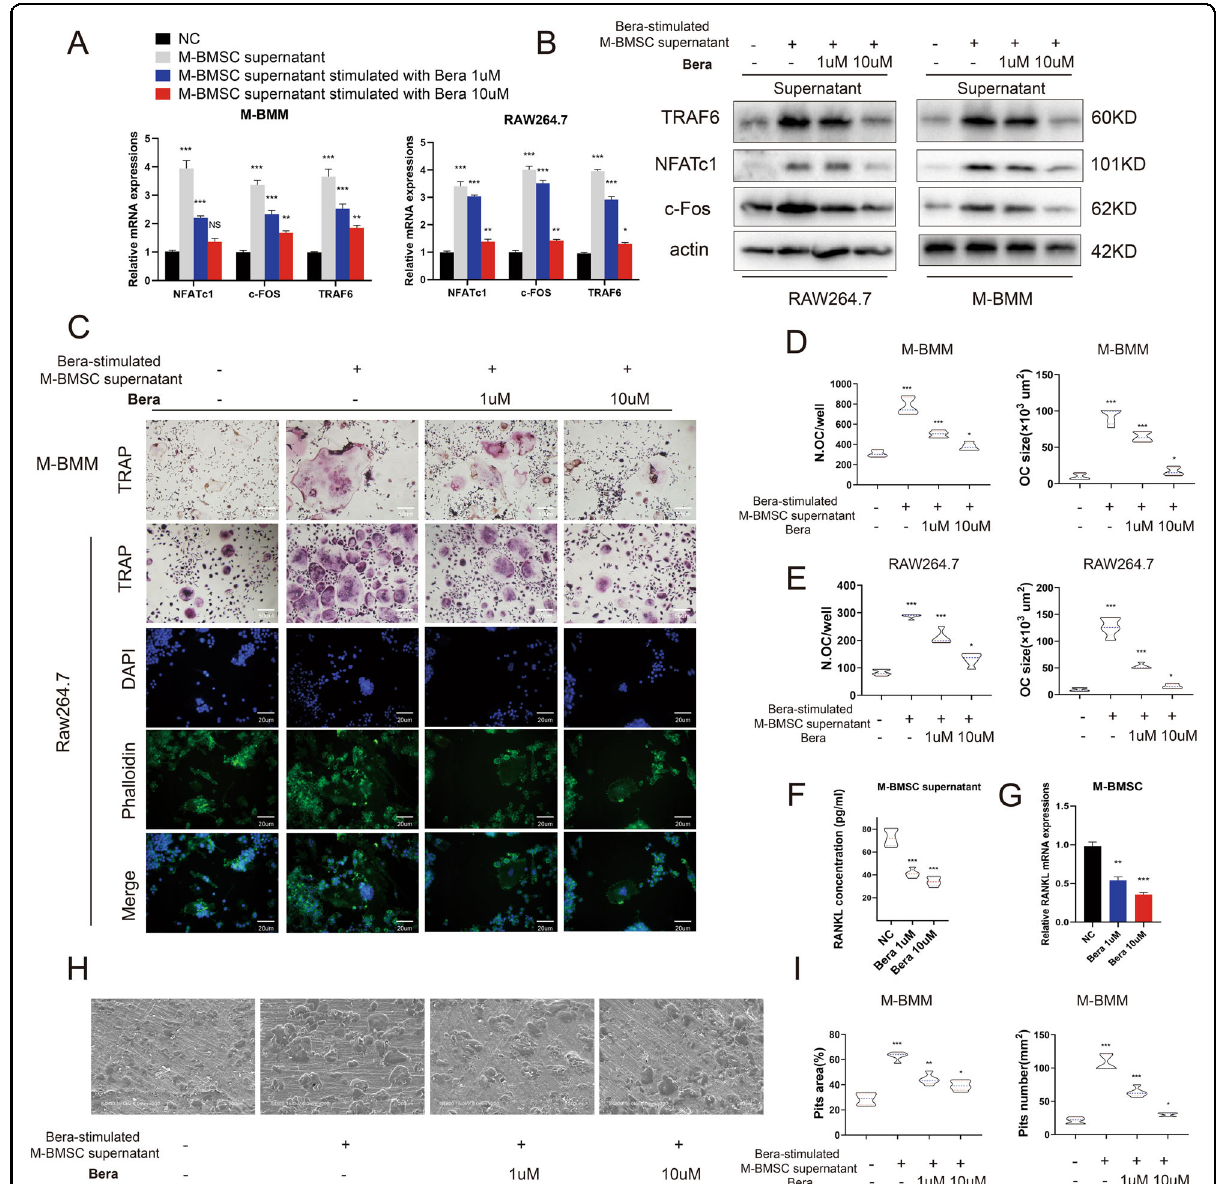
Fig. 4 Beraprost promotes osteoclast differentiation through BMSCs in vitro. A Quantitative RT-PCR analysis of mRNA expression of TRAF6, NFATc1, and c-Fos in M-BMM and Raw264.7 cells cultured with the supernatant of beraprost-stimulated M-BMSCs. Results are shown as mean ± SD. n = 5; * P < 0.05, ** P < 0.01, and *** P < 0.001 by ANOVA with Tukey ’ s post-hoc test. B Western blotting images showing protein expression of TRAF6, NFATc1, and c-Fos in M-BMM and Raw264.7 cells cultured with the supernatant of beraprost-stimulated M-BMSCs. C Representative images of TRAP staining in M-BMM and Raw264.7 after 7 days of osteoclast differentiation in the presence of M-BMSCs supernatant stimulated with beraprost. Scale bar, 50 µm. Representative images of fl uorescent staining of Raw264.7 cells are shown. The cytoskeleton was stained with FITC-conjugated phalloidin and the nucleus was stained with DAPI. RANKL (30 ng/mL) was used in all groups. Scale bar, 20 µm. D , E Number and size of osteoclasts. TRAP- positive cells with at least three nuclei were de fi ned as osteoclasts. n = 5; * P < 0.05, ** P < 0.01, and *** P < 0.001 by ANOVA with Tukey ’ s post-hoc test. F Concentration of RANKL in the supernatant. n = 5; *** P < 0.001 by ANOVA with Tukey ’ s post-hoc test. G Quantitative RT-PCR analysis of mRNA expression of RANKL in M-BMSCs treated with beraprost. n = 5; ** P < 0.01, *** P < 0.001 by ANOVA with Tukey ’ s post-hoc test. H Representative images of bone resorption pits captured by scanning electron microscope. Scale bar, 200 µm. I Quantitative analyses of pit number and area. Results are shown as mean ± SD; n = 5; * P < 0.05, ** P < 0.01, and *** P < 0.001 by ANOVA with Tukey ’ s post-hoc